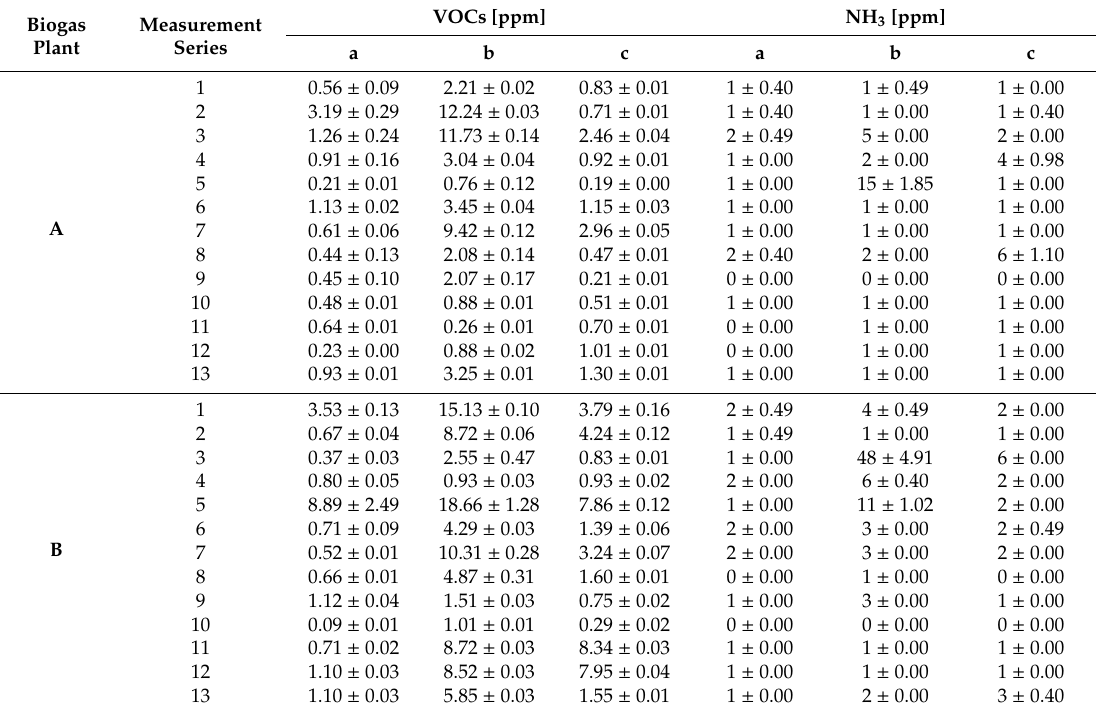
Table 3. Measurement results for the waste storage section.